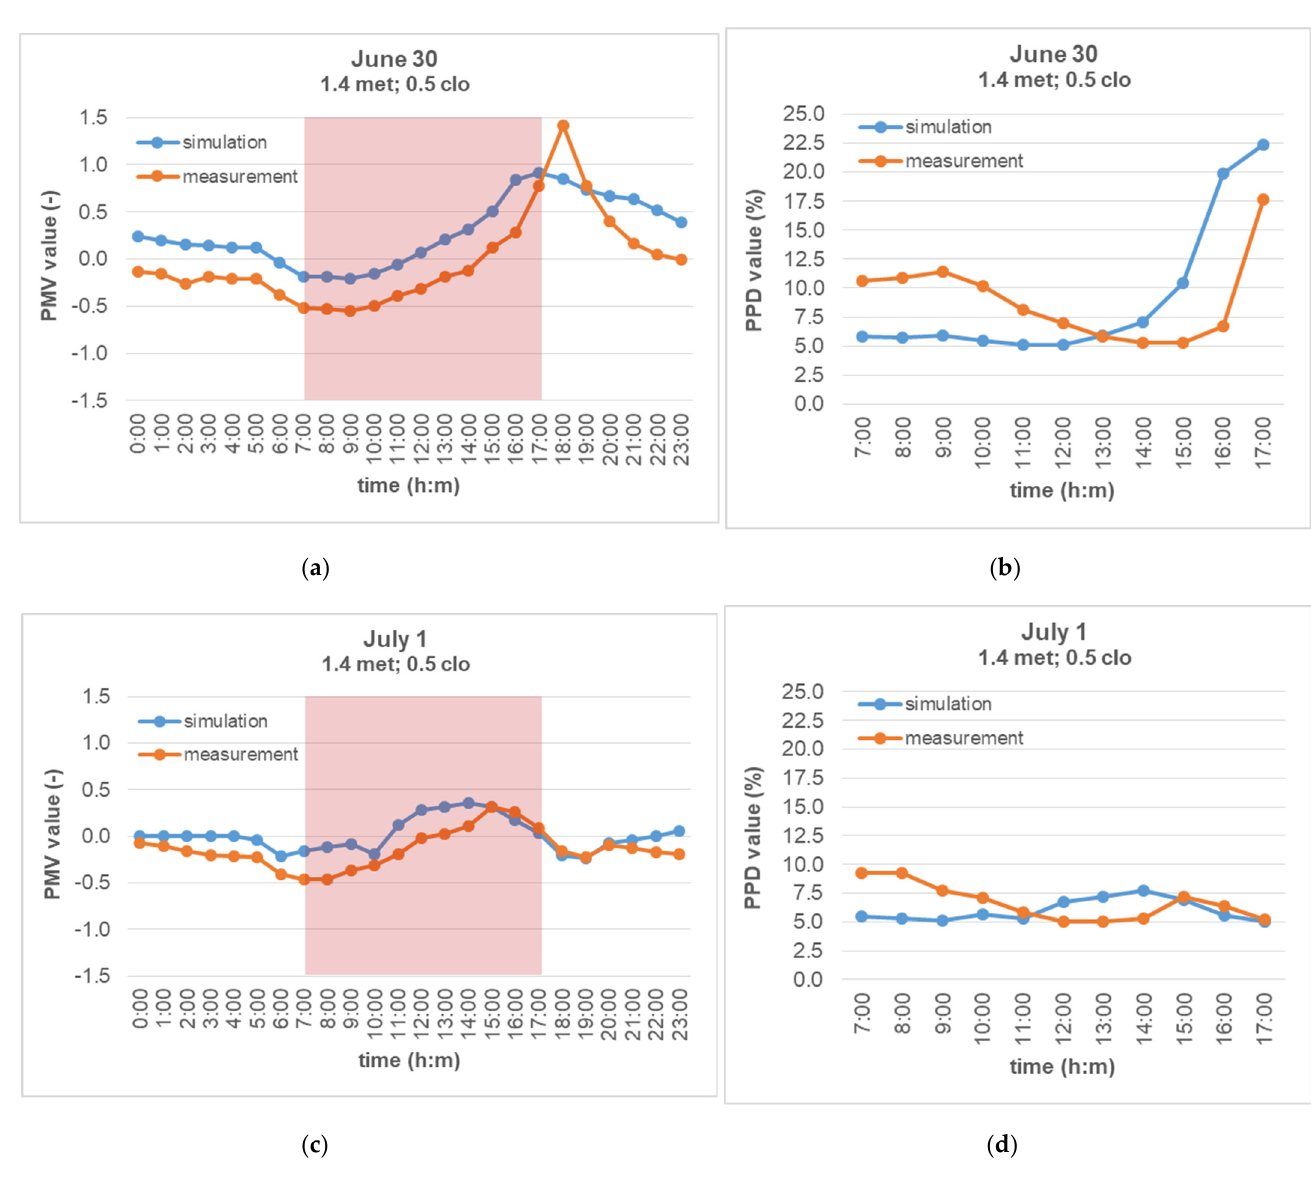
Figure 14. Evaluation of PMV and PPD indices using the highest values of metabolism (1.4 met) and clothing resistance (0.5 clo): ( a ) PMV on 30 June, ( b ) PPD on 30 June, ( c ) PMV on 1 July, ( d ) PPD on